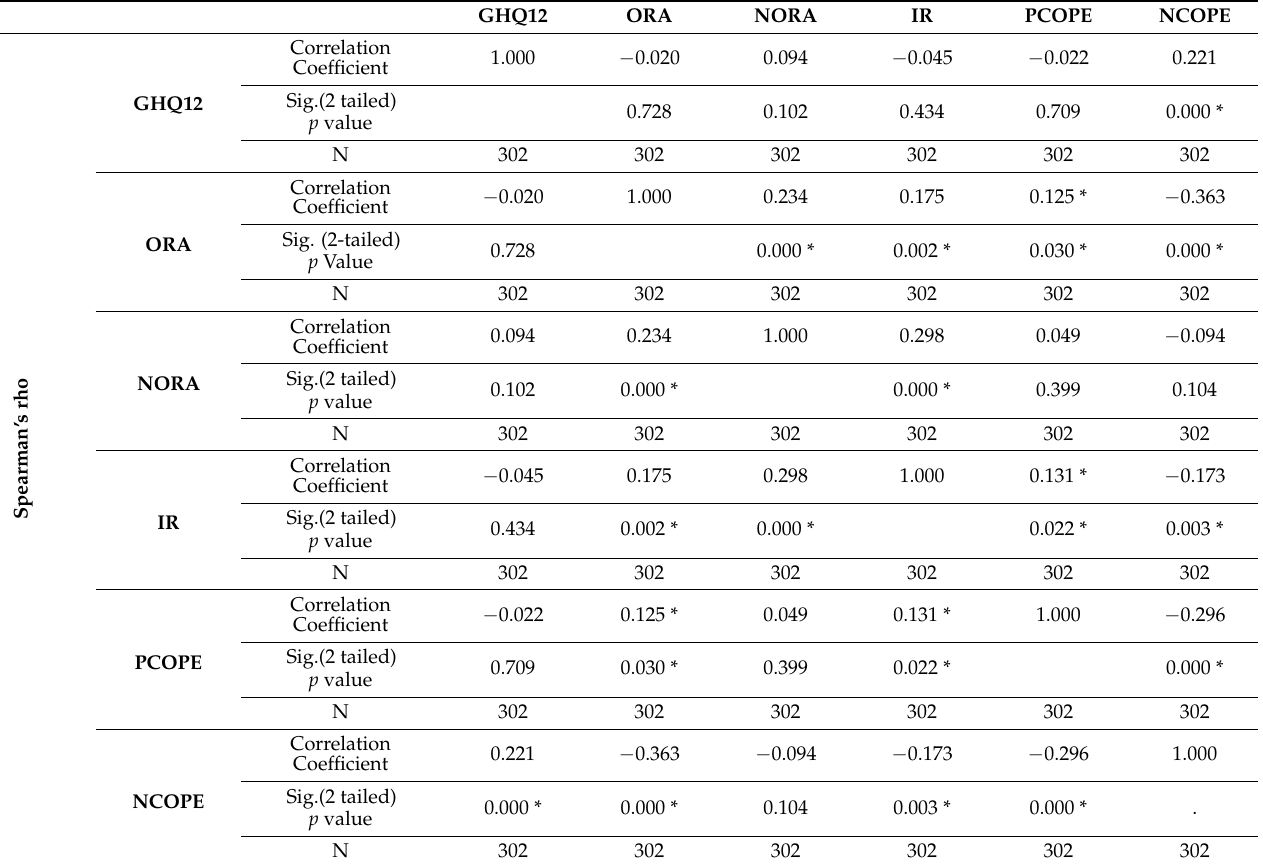
Table 4. Correlations among, religious coping methods, religious practice and psychological